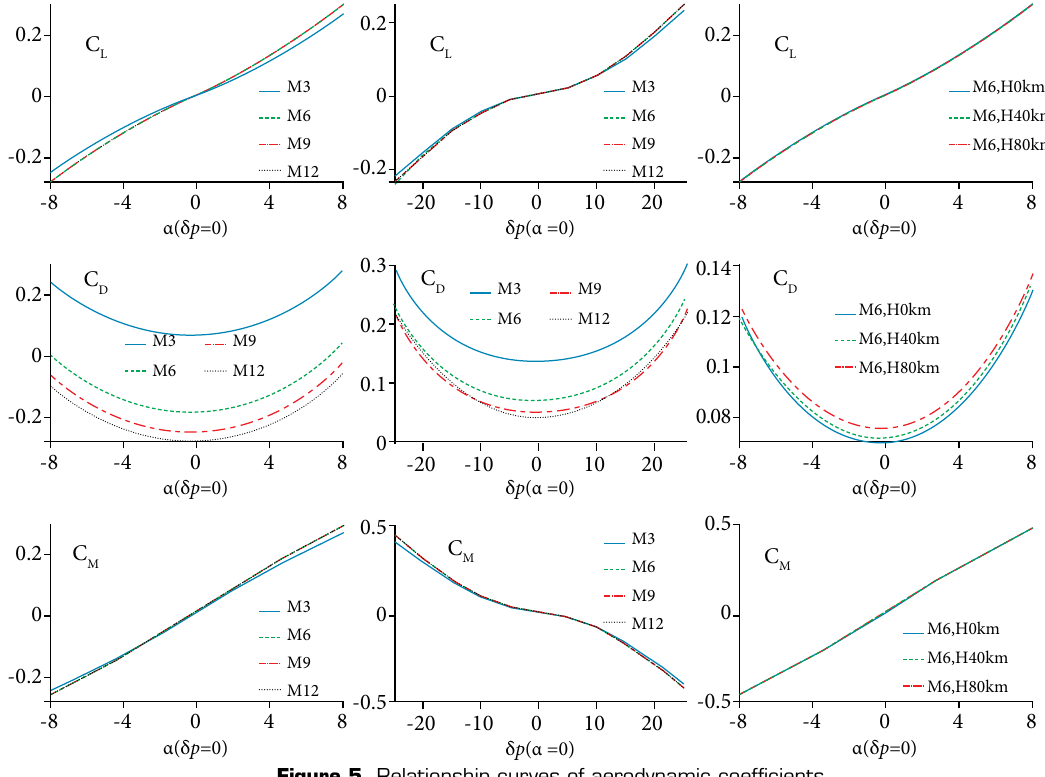
Figure 5. Relationship curves of aerodynamic